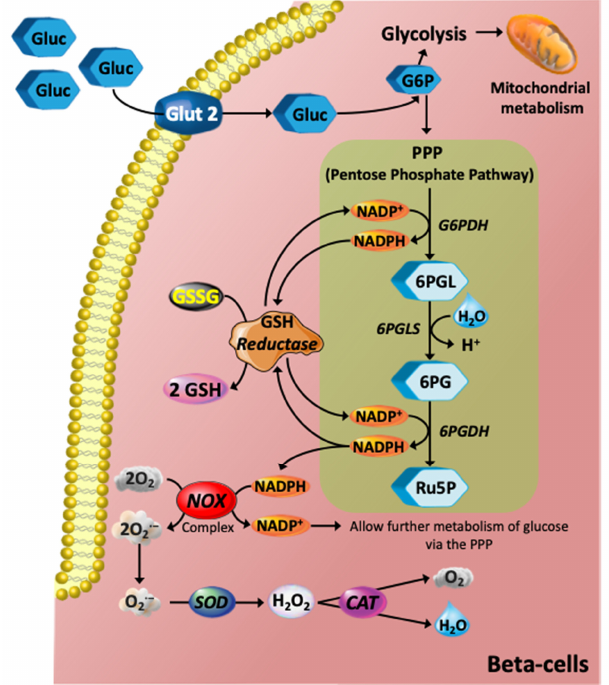
Figure 2. Glucose metabolism via the PPP and its role in redox pathways. The glycolytic intermediate glucose 6-phosphate (G6P) can be diverted into the PPP, which is an NADPH-producing pathway. In turn, NADPH is an electron donor for the de novo glutathione (GSH) system mediated by GSH reductase using glutathione disulfide (GSSG) to generate reduced glutathione (GSH). The GSH system is the most abundant intracellular non-protein thiol that exerts essential antioxidant roles against ROS in all animal cells. NADPH is also an important electron donor for the NADPH oxidase (NOX) complex, and hence further contributing to stimulation of glucose metabolism via PPP. The NOX complex, however, produces the superoxide anion (O 2· − ), which is an anion radical that can be rapidly converted to hydrogen peroxide (H 2 O 2 ) by the action of superoxide dismutase (SOD) and further catalysed by catalase (CAT) producing oxygen and H 2 O. Abbreviations: 6PG, 6-phosphogluconate; 6PGDH. 6-phosphogluconate dehydrogenase; 6PGL, 6-Phosphogluconolactonase; 6PGLS, 6-phosphogluconolactonase; Ru5P, ribulose-5-phosphate.